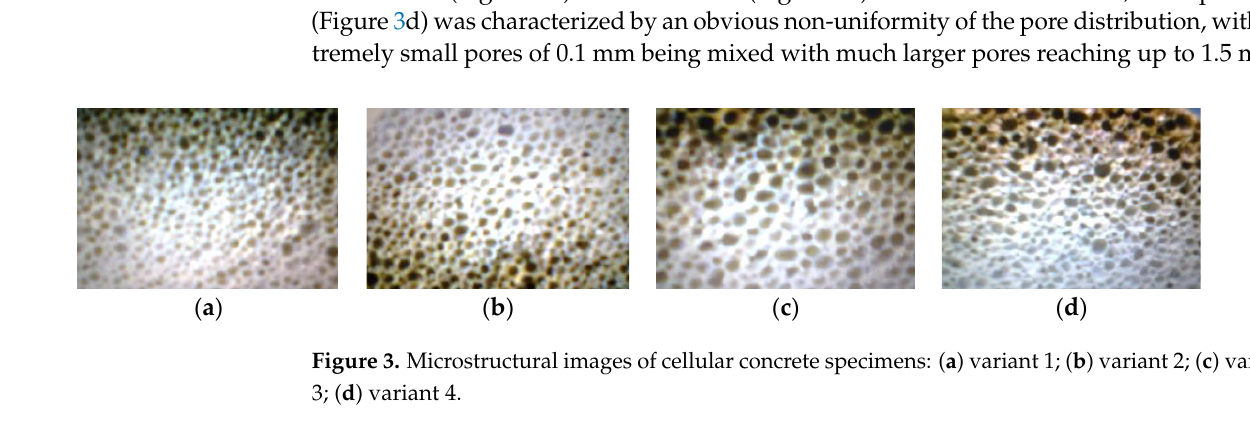
Figure 2. Cross-section appearance of cellular concrete specimens: ( a ) variant 1; ( b ) variant 2; ( c ) variant 3; ( d ) variant 4.